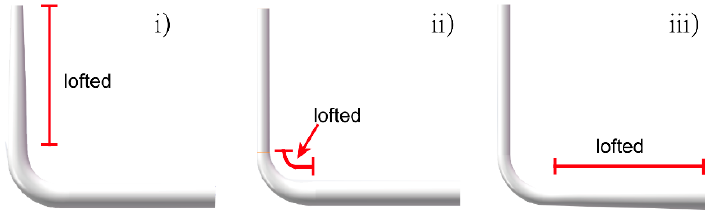
Figure 17. Improvement for C ‐ r i / r o compared to I ‐ X and I ‐ L (0 ≤ r ≤ 18 ).